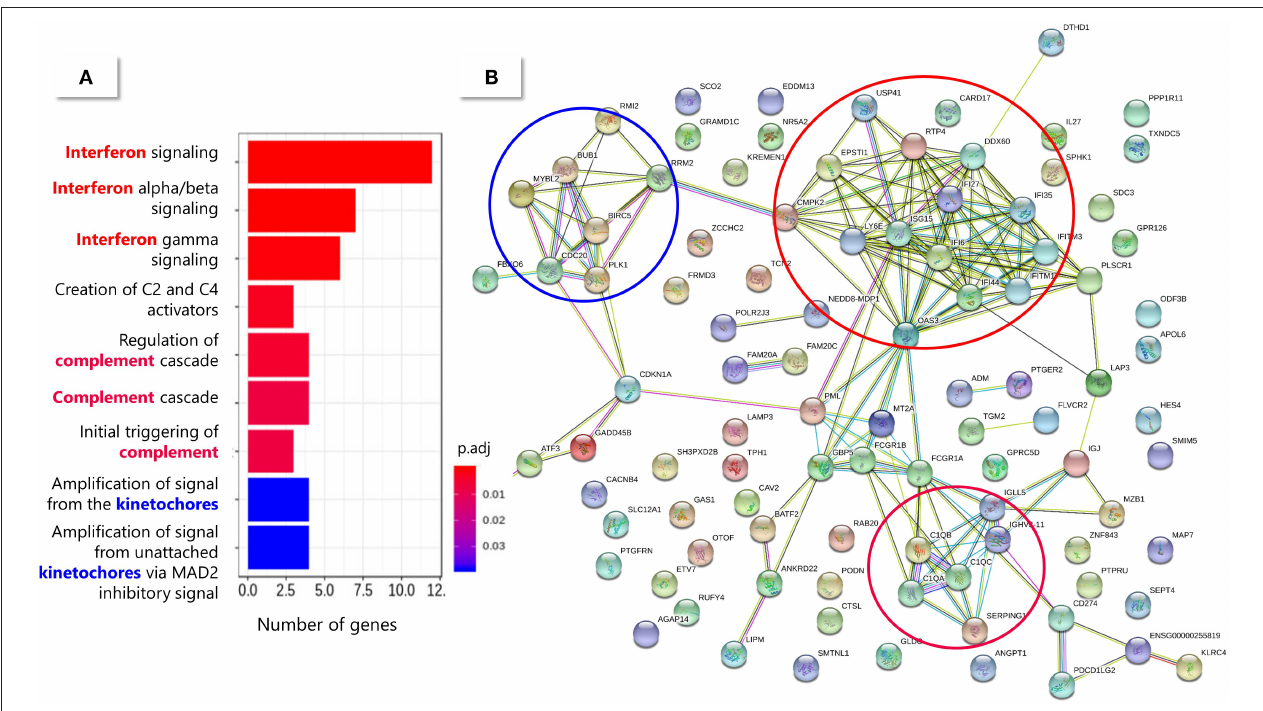
FIGURE 6 | Pathway enrichment analysis of the 150 DE genes between TB-like and NoTB-like subgroups. (A) Enriched pathways from the Reactome database. The color of the bars indicates the significance [adjusted p-value (padj)] of the enrichment. (B) String protein association network. Each node (circle) represents a protein (identified by their coding gene) and the edges represent protein interactions. The main enriched pathways have been circled in a matching color with the correspondent Reactome pathway.